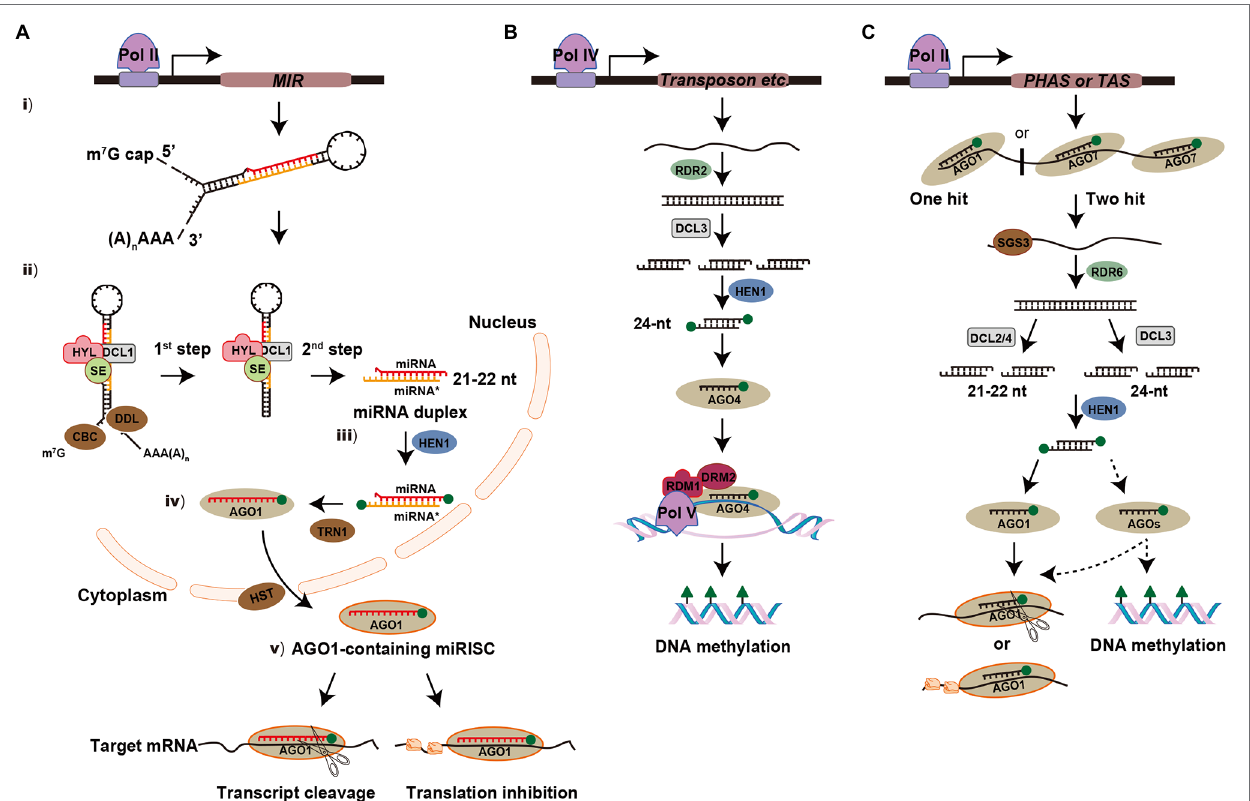
FIGURE 1 | Biogenesis and modes of action of microRNAs (miRNA) and small interfering RNAs (siRNA) in plants. (A) Overview of miRNA pathway. MIR gene is transcribed by polymerase II (Pol II) to generate a long single-stranded primary miRNA (pri-miRNA) and form a stem-loop or hairpin secondary structure. The pri- miRNA is firstly cleaved into stem-loop precursor miRNA (pre-miRNA) and then processed into miRNA-miRNA* duplex. In this complex process, DCL1 forms a D-bodies with HYPONASTIC LEAVES1 (HYL1) and SE to ensure the accurate and efficient splicing of pre-mRNA. Other cofactors are involved for proper processing, such as cap-binding complex (CBC) and Dawdle (DDL). The miRNA-miRNA* duplex is then methylated by HUA ENHANCER1 (HEN1) to protect the 3' ends from uridylation. The guide strand (miRNA) is incorporated into Argonaute-1 (AGO1) with the aid of TRANSPORIN 1 (TRN1) and then exported from the nucleus to the cytoplasm via HASTY (HST). In the cytoplasm, mature miRNA directs post-transcriptional gene silencing (PTGS) via transcript cleavage or translational repression. The green balls at the ends of miRNA-miRNA* duplex represent 2 ' - O -methy groups. (B) Overview of the heterochromatic siRNA (hc-siRNA) pathway. hc-siRNAs are derived from transposable and repetitive elements. The biogenesis of hc-siRNA requires Polymerase IV (Pol IV) to transcribe a single- stranded RNA (ssRNA) and synthesis into a double-stranded RNA (dsRNA) by RDR2. The dsRNA is then processed into 24-nt siRNA by DCL3. After the siRNA is incorporated into AGO4, Pol V transcribes transcripts that base pairing with siRNA and the siRNA-AGO4 complex is recruited. AGO4, RNA-DIRECTED DNA METHYLATION 1 (RDM1) and DOMAINS REARRANGED METHYLTRANSFERASE 2 (DRM2) trigger DNA methylation at the transcriptional gene silencing (TGS) level. (C) Overview of the phased siRNA (phasiRNA) pathway. phasiRNAs originated from phasiRNA-generating ( PHAS ) or trans-acting siRNA ( TAS ) loci are transcribed by Pol II and their precursors are cleaved via the miRNA “one-hit” system (AGO1-miRNA complex) or the “two-hit” system (AGO7-miRNA complex). SUPPRESSOR OF GENE SILENCING3 (SGS3) stabilizes the 5'- or 3'-cleaved fragments to protect them from AGO-mediated slicing. Then the primary siRNAs are converted into dsRNAs by RDR6 and further processed into 21- or 22-nt siRNAs by DCL2 and DCL4 or 24-nt siRNAs by DCL3. For further processing, some of them will be recruited by the AGO1 complex and some of them may be incorporated into other uncertain AGOs to trigger the cleavage of target mRNA, translational repression or DNA